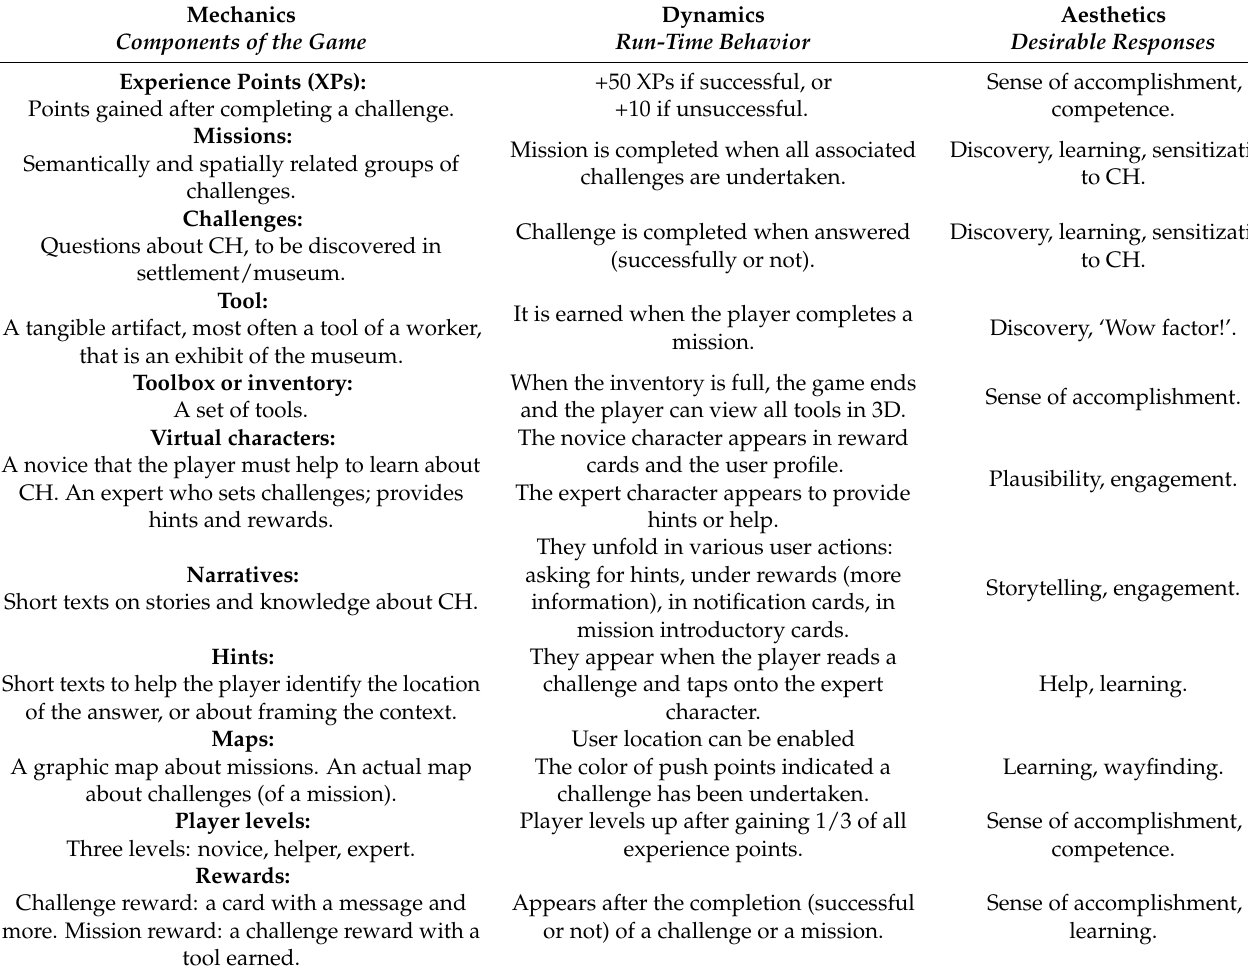
Table 3. Mechanics, Dynamics, and Aesthetics of the Mobile